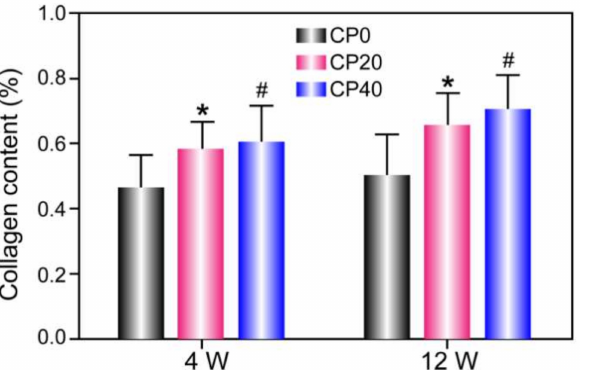
Figure 10. Semi-quantitative expression experiments of collagen fibers. The * p < 0.05 CP20 group vs. CP0 group and # p < 0.05 CP20 group vs. CP40 group. The values are represented as mean ± SD (n =